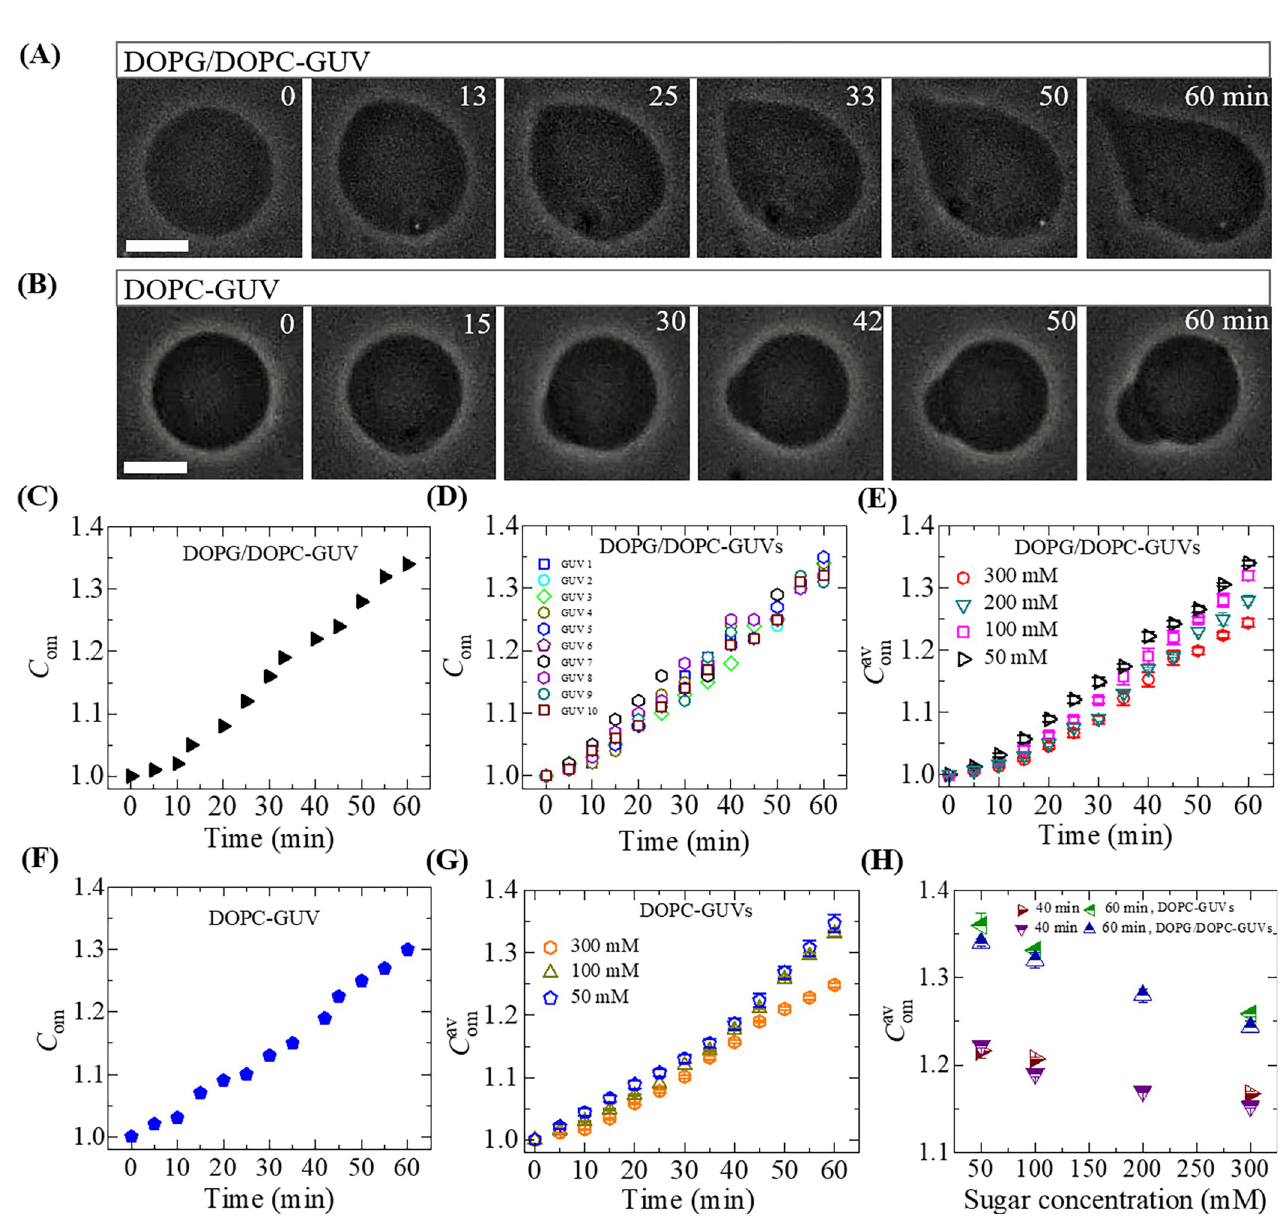
Fig 1. The deformation and compactness of charged and neutral GUVs induced by 3.33 μ g/mL NPs. Phase contrast images show the deformation of a (A) 40%DOPG/60%DOPC-GUV and (B) DOPC-GUV in the presence of 50 mM sugar concentration. The numbers on each image indicate the time in minute after addition of NPs. Scale bar is 15 μ m. The time course of the change in C of (C) 40%DOPG/60%DOPC-GUV and (F) DOPC-GUV as shown in (A) and om (B), respectively. (D) The time course of the change in C om of 10 ‘single 40%DOPG/60%DOPC-GUVs’ in an independent experiment at 50 mM sugar concentration. The time course of average compactness ( C av ) of many (E) 40%DOPG/60%DOPC-GUVs and (G) DOPC-GUVs at c = 50, 100, 200 and 300 om mM. (H) The sugar concentration-dependent C av at different times for 40%DOPG/60%DOPC and DOPC-GUVs. Average values with standard deviations of om C om were determined from 3 independent experiments using 15 − 18 GUVs in each independent